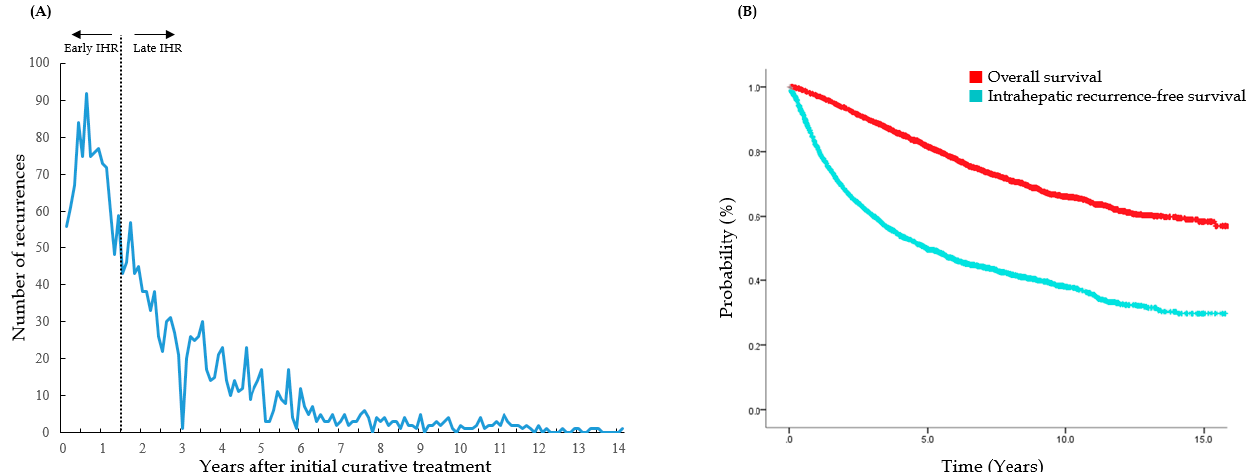
Figure 2. ( A ) Number of IHRs observed after initial curative treatment. The absolute counts of IHR are plotted in monthly bases. Recurrence within 1.5 years from initial curative treatment was grouped as early IHR, and recurrence after 1.5 years from initial curative treatment was grouped as late IHR. ( B ) Kaplan-Meier curves of OS and IHRFS. The 2-year and 5-year OS rates were 93.6% and 81.6%, respectively. The 2-year and 5-year IHRFS rates were 68.3% and 49.5%, respectively. IHR, intrahepatic recurrence; OS, overall survival; IHRFS, intrahepatic recurrence-free survival.